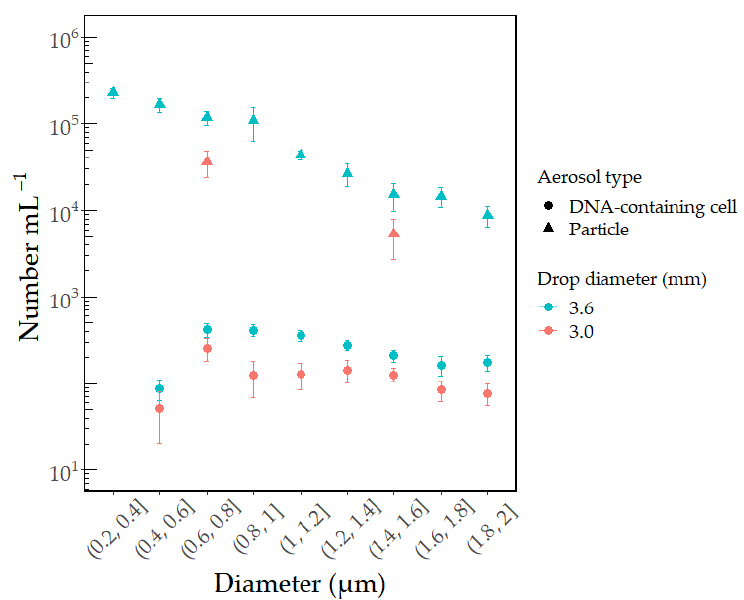
Figure 3. Total particles (triangle) and DNA-containing cells (circle) scavenged per mL of 3.6 (blue) or 3.0 (red) mm drops. The data are binned by particle/cell diameter (µm), as described in Section 2.5. Error bars indicate standard error of the mean, n = 4.